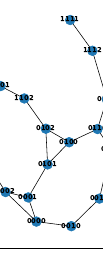
Figure 6. Largest connected component in BC 2,2 .